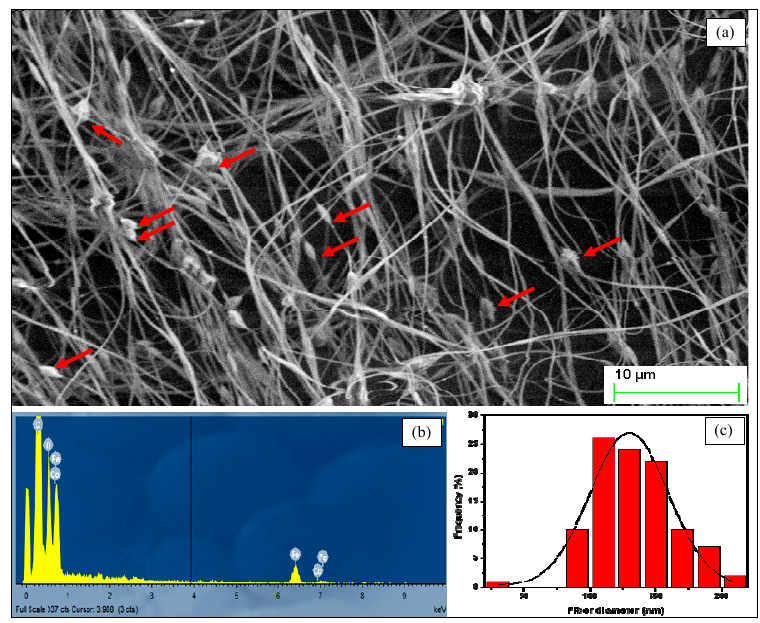
Figure 5. SEM analysis of the nanocomposite fiber: SEM image ( a ) EDX elemental mapping ( b ) nanofiber size distribution ( c ).